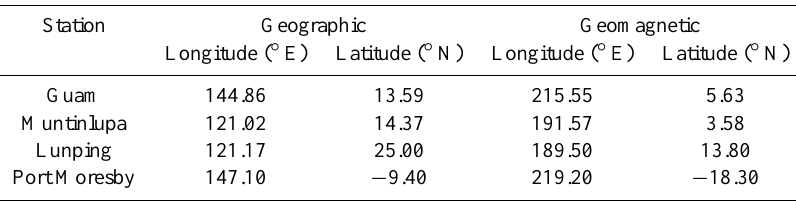
Table 1. List of (top one) GPS ground-based receiver, (middle two) ground magnetometer and (bottom one) ionosonde station sites used for data